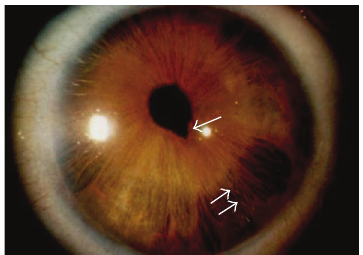
Figure 4: Corectopia ( ↑ ) and hypoplasia ( ↑↑ ) of the iris in patient